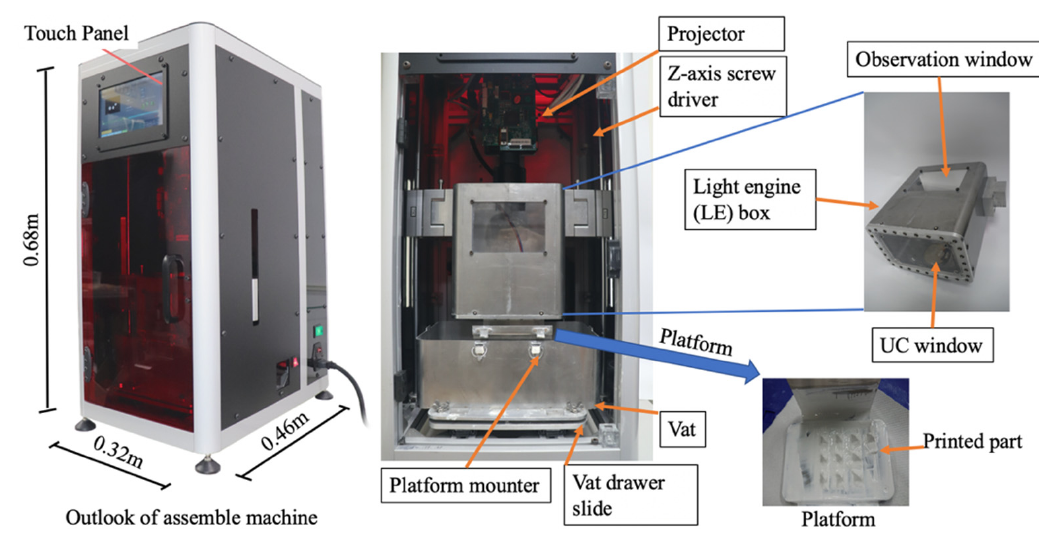
Figure 6. The assemble machine and all moduli.